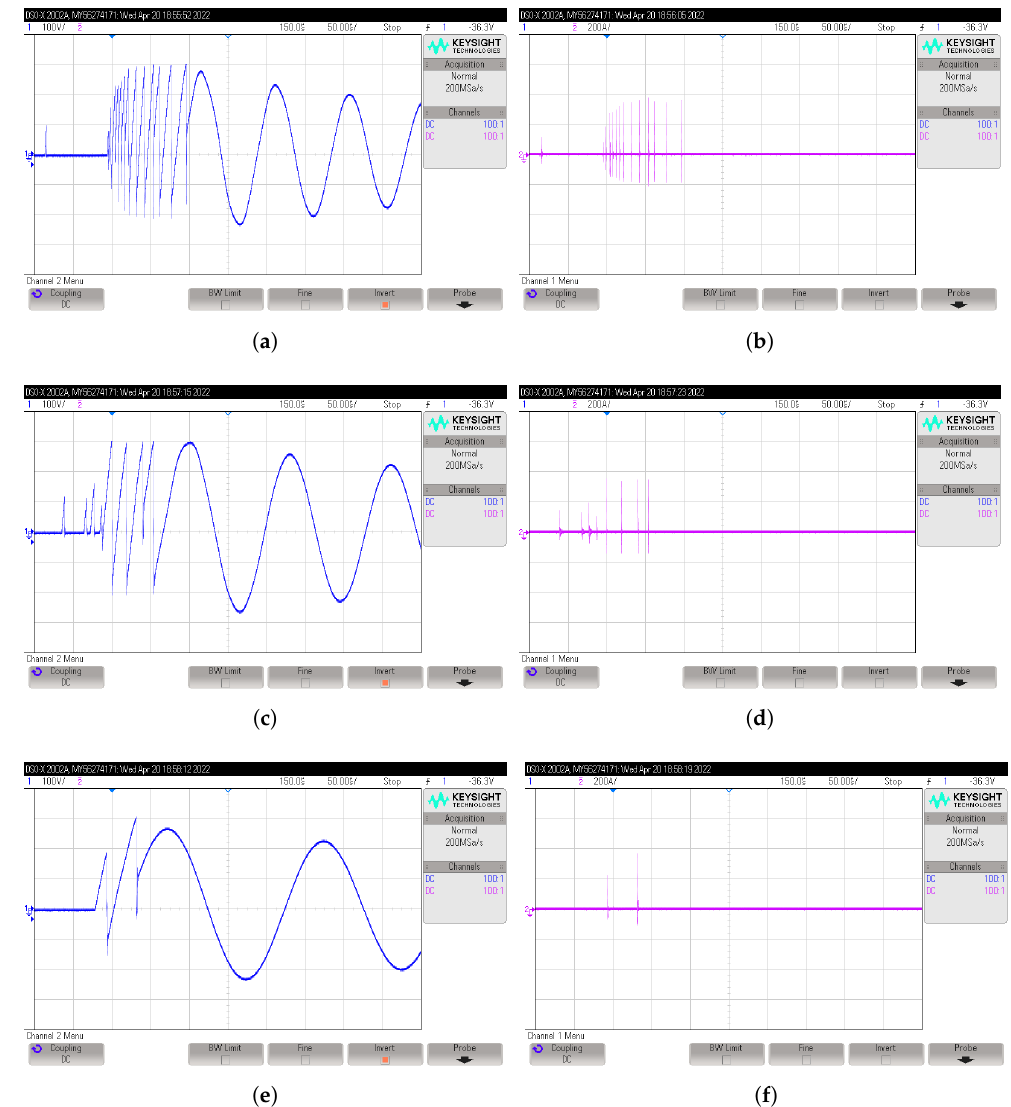
Figure 6. Waveforms of voltage and current for different capacitance. ( a ) Voltage 1 nF (parameters: 100 V/div, 50 us/div). ( b ) Current 1 nF (parameters: 200 A/div, 50 us/div). ( c ) Voltage 2 nF (parameters: 100 V/div, 50 us/div). ( d ) Current 2 nF (parameters: 200 A/div, 50 us/div). ( e ) Voltage 5 nF (parameters: 100 V/div, 50 us/div). ( f ) Current 5 nF (parameters: 200 A/div, 50